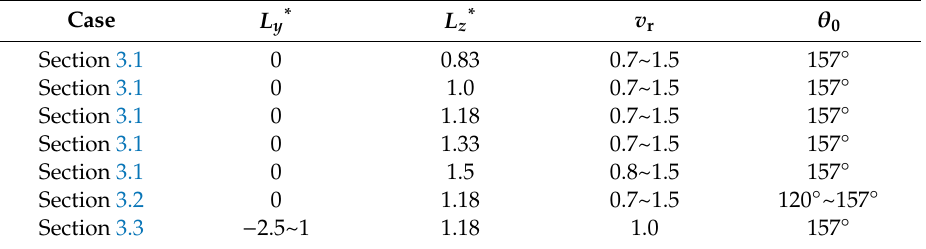
Table 1. The cases for two successive droplets impacting an inclined surface in the present